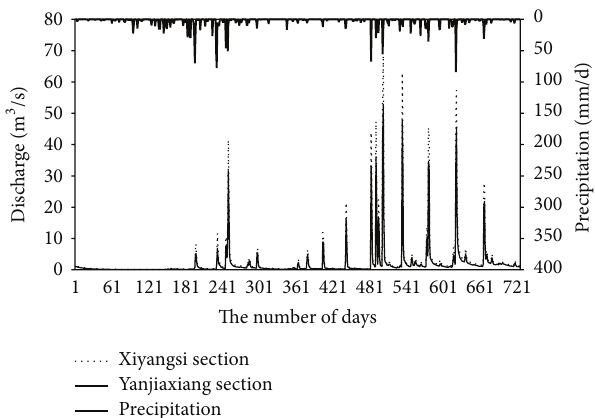
Figure 5: Precipitation and simulated daily hydrographs at water quality monitoring